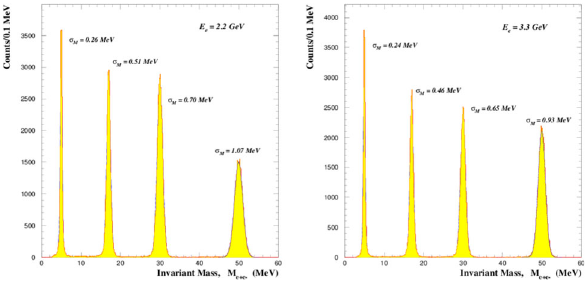
Fig. 49 The e + e − invariant mass resolution at 2.2 GeV (left) and 3.3 GeV (right)